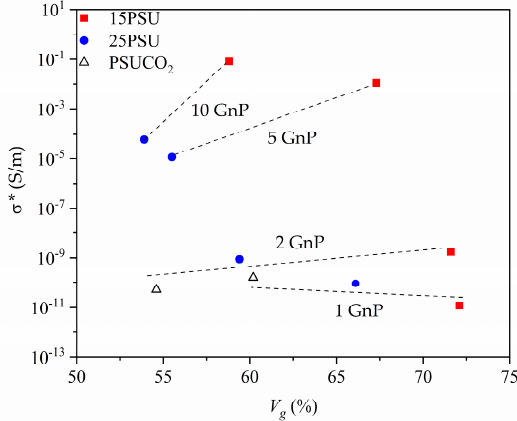
Figure 6. Effect of the gas volume percentage on the electrical conductivity of PSU – GnP microcellular nanocomposites represented by linear fits.